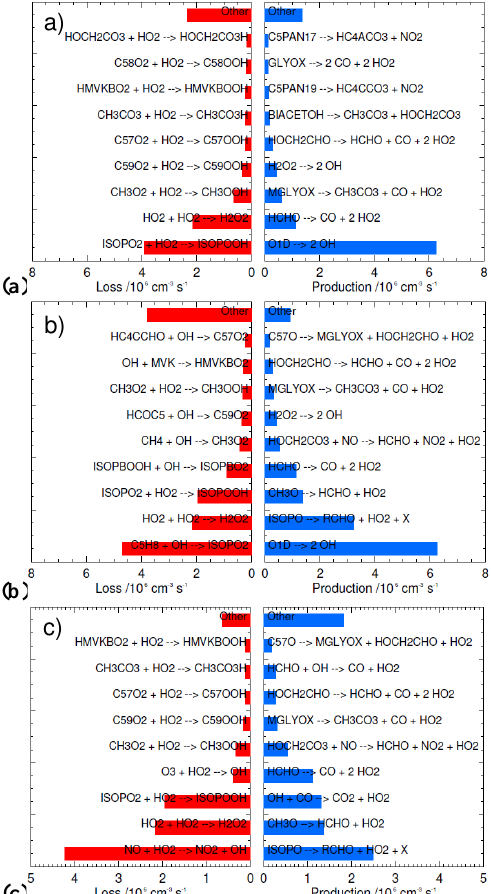
Fig. 7. Processes controlling the instantaneous production and loss of (a) RO x (b) HO x and (c) HO 2 for a typical data point in the forest boundary layer (shown in red in Fig. 4). Species names are as given in the MCM.